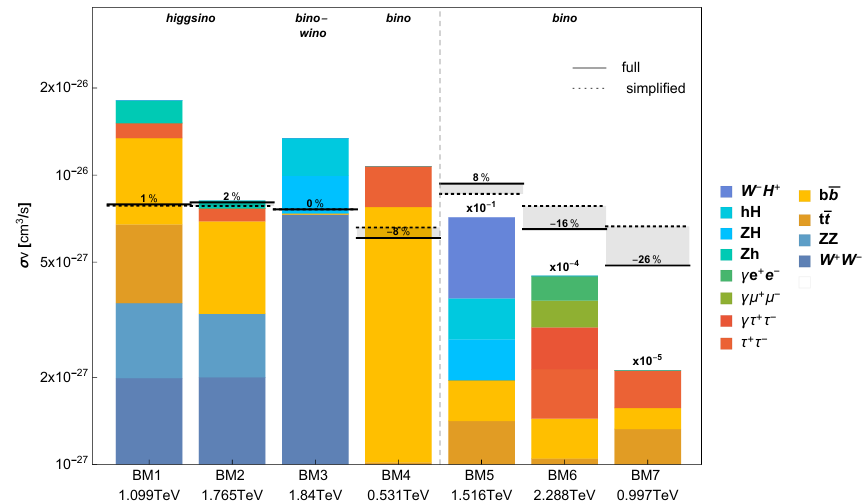
Figure 6. Comparison between (cid:27)v 95%C.L. (full calc.) and (cid:27)v 95%C.L. (simpli(cid:12)ed) for the 7 selected 0 0 representative benchmark points given in table 3. The color code tracks the branching fractions for dominant present-day annihilation channels, while the height of the column gives the theoretical value of the cross section (cid:27)v 0 . The relative di(cid:11)erence between the full and simpli(cid:12)ed procedure is highlighted in percentage. Benchmark points to the right of the vertical dashed line do not yield the correct relic abundance and feature annihilation cross section much below the projected limits. They are characterized by a large number of di(cid:11)erentiated annihilation channels and, in particular, include large fraction to (cid:28) + (cid:28) (cid:0) . These are the spectra producing the maximal